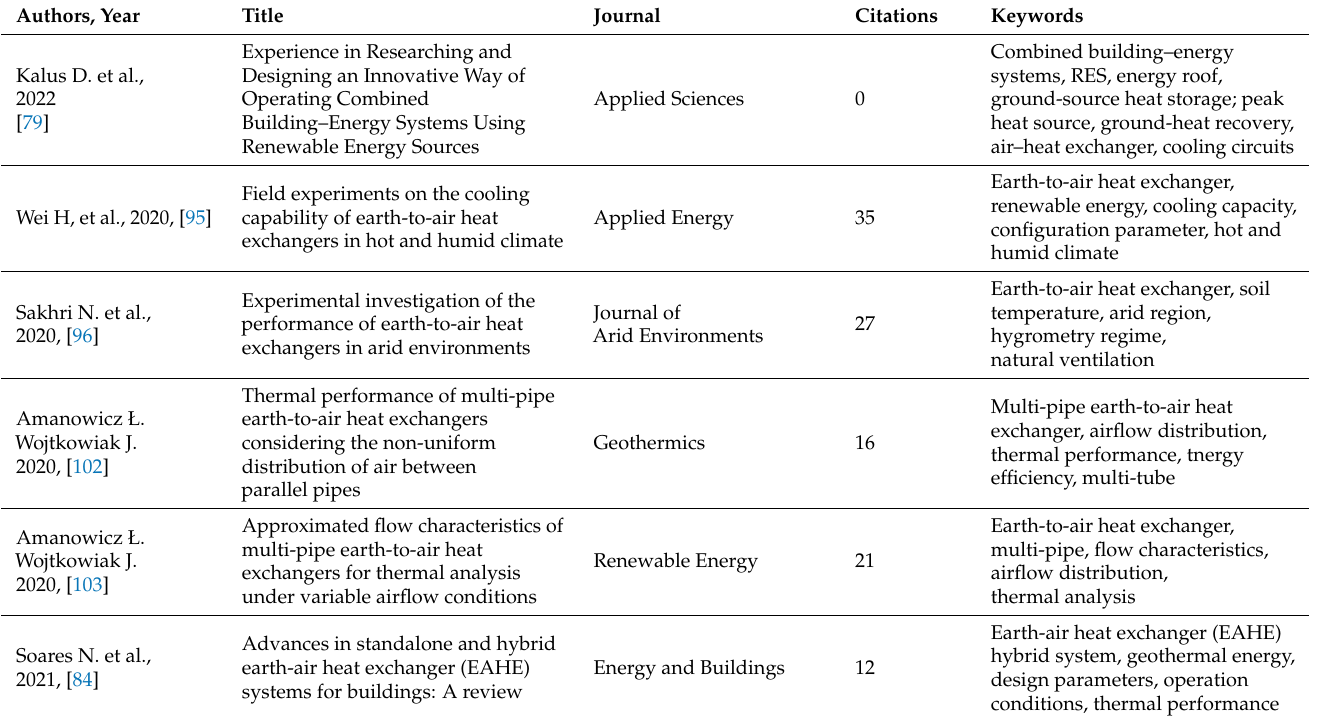
Table 5. Reviewed papers on earth-to-air heat